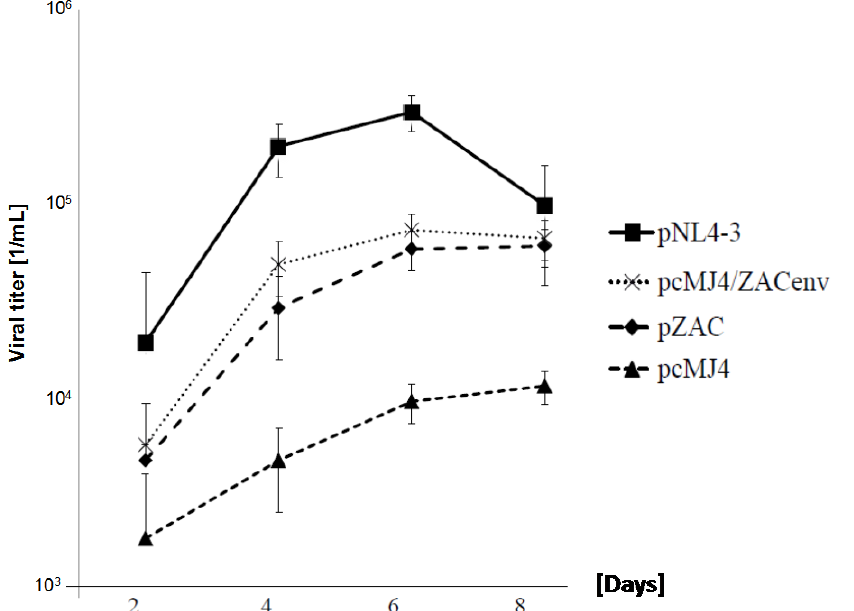
Figure 2. pZAC replicates faster in PBMC than pcMJ4. Growth kinetics of subtype B and C viruses on PBMCs. Infectious viruses (MOI: 0.05) were cultured for 8 days on